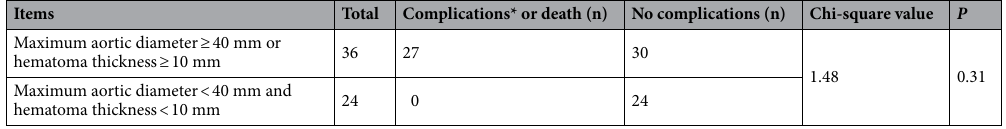
Table 9. Comparison of the maximum aortic diameter and hematoma thickness for the treatment of Stanford B IMH. *Progression of aortic dissection, pseudoaneurysm, rupture, visceral arterial perfusion, lower limb ischemia.